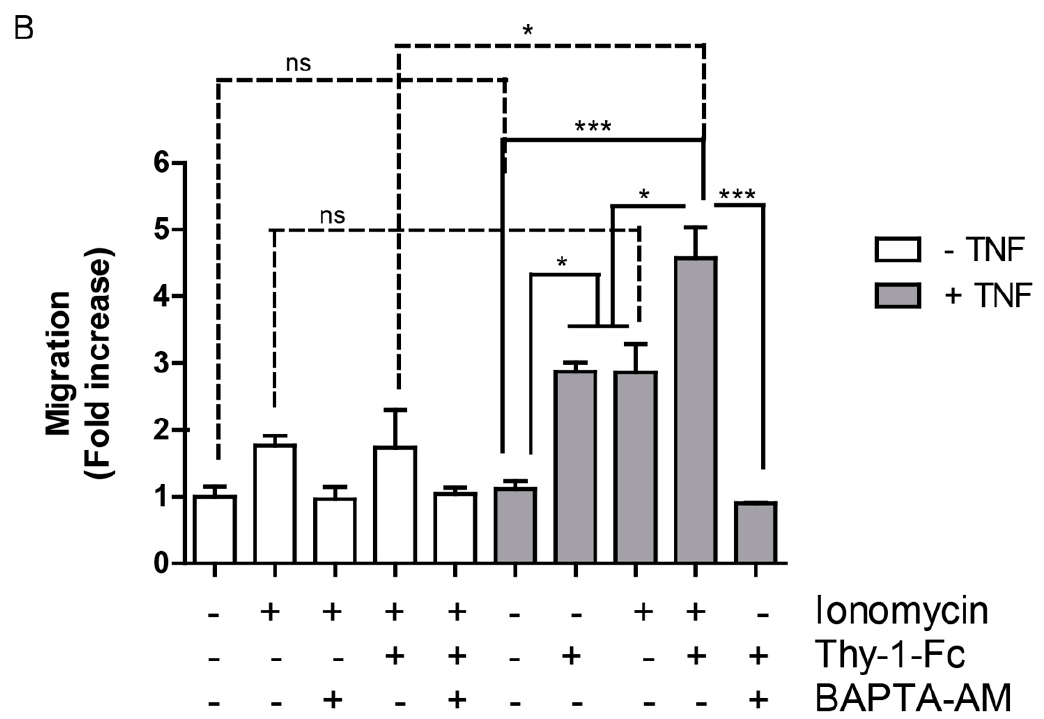
Figure 4. Hemichannel opening and ionomycin-induced intracellular calcium (Ca 2+ ) increase are necessary, but not sufficient, to promote Thy-1-induced cell migration. ( A ) Quantification of Lucifer yellow uptake by primary astrocytes pre-incubated with TNF (10 ng/mL for 48 h), BAPTA-AM (5 µM for 30 min) and then stimulated with Thy-1-Fc or ionomicyn (1 µM) for 10 min. Values in the graph correspond to the mean fluorescence intensity normalized to the non-stimulated condition; ( B ) Cell migration quantification of primary astrocytes incubated as indicated in ( A ). Cells were allowed to migrate for 2 h in inserts pre-coated on the lower side with fibronectin (2 µg/mL). Migrating cells were visualized by crystal violet staining of cells on the lower side of the inserts. Data were normalized to non-treated cells and are shown as the average of 7 different fields from each independent experiment, n = 3, ns = non-significant, * p < 0.05, ** p < 0.01, *** p < 0.001. Solid lines indicate comparisons of pairs under the same experimental conditions, i.e. − TNF or +TNF. Dashed lines are comparisons of pairs between experimental conditions, i.e. between − TNF or +TNF.